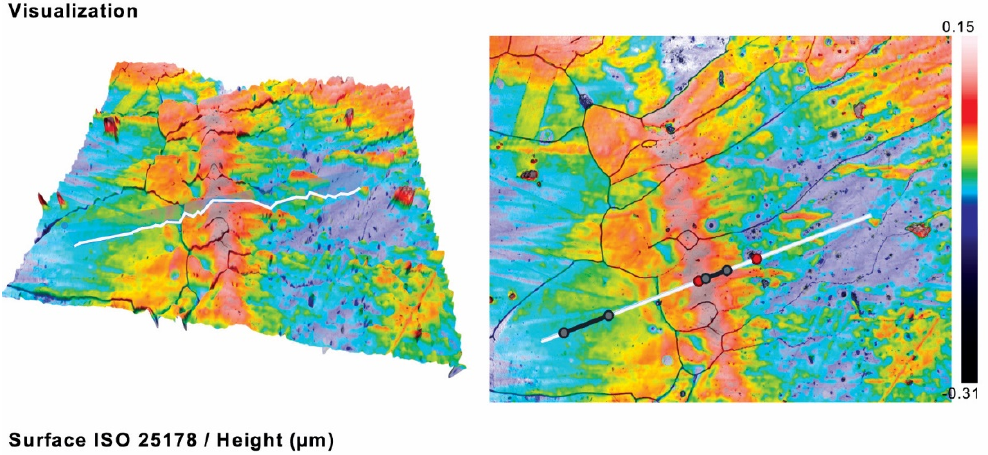
Figure 15. Test results of profile analysis for the zone of Incoloy 800HT nickel alloy. The analysis was performed along the white line.